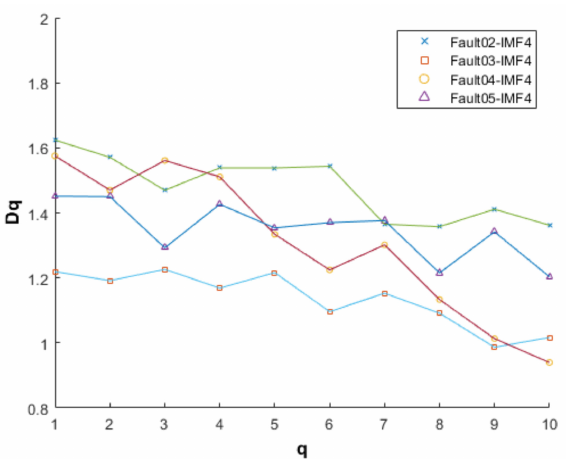
Figure 24. IMF4‑EMD mathematical morphology fractal dimension map.